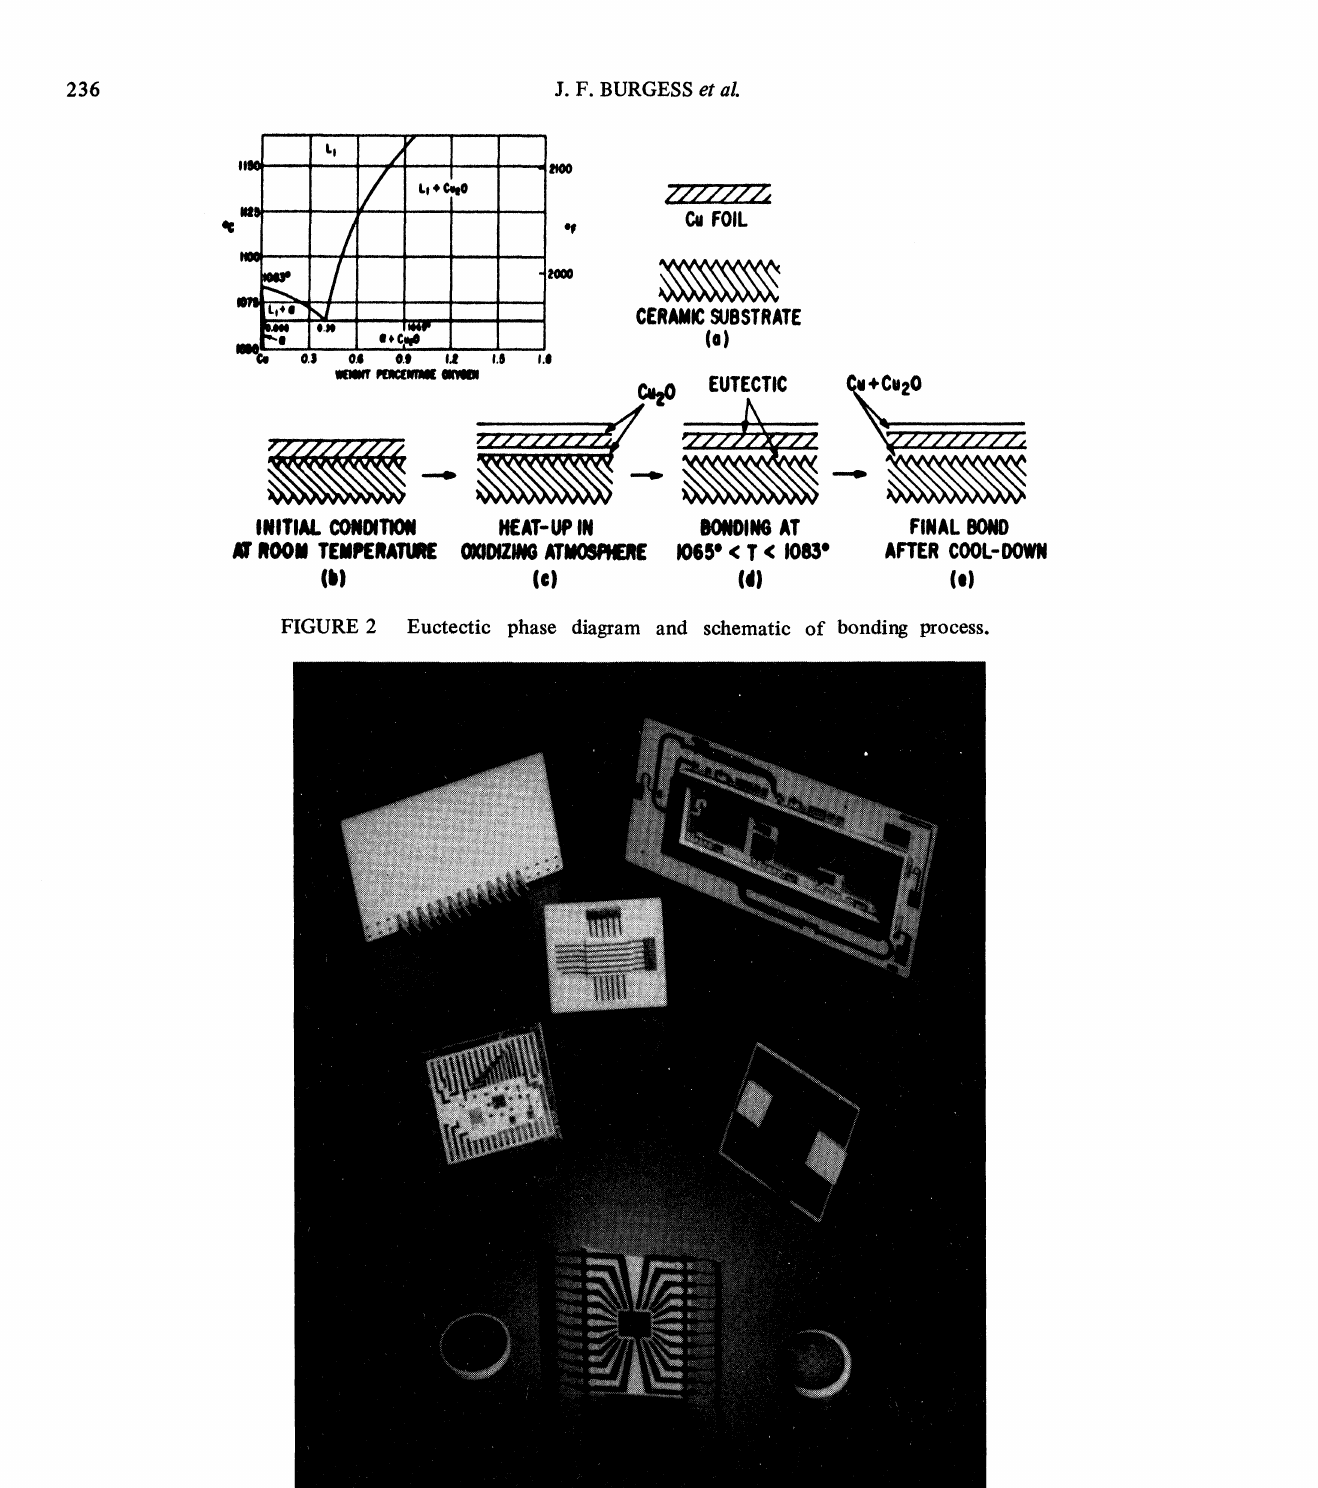
FIGURE 3 Direct bonded copper